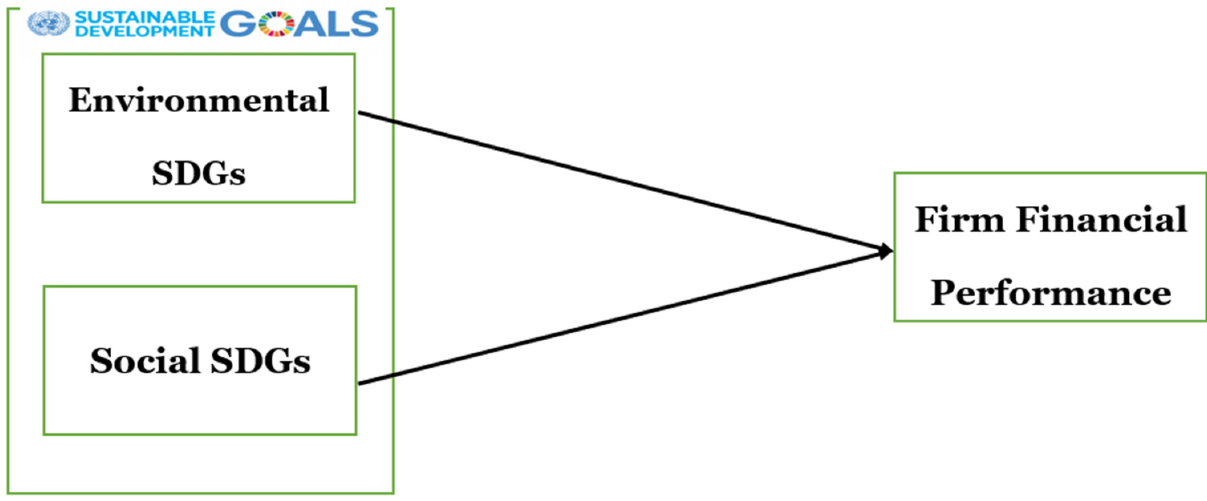
Figure 1. SDGs and firms’ financial performance.